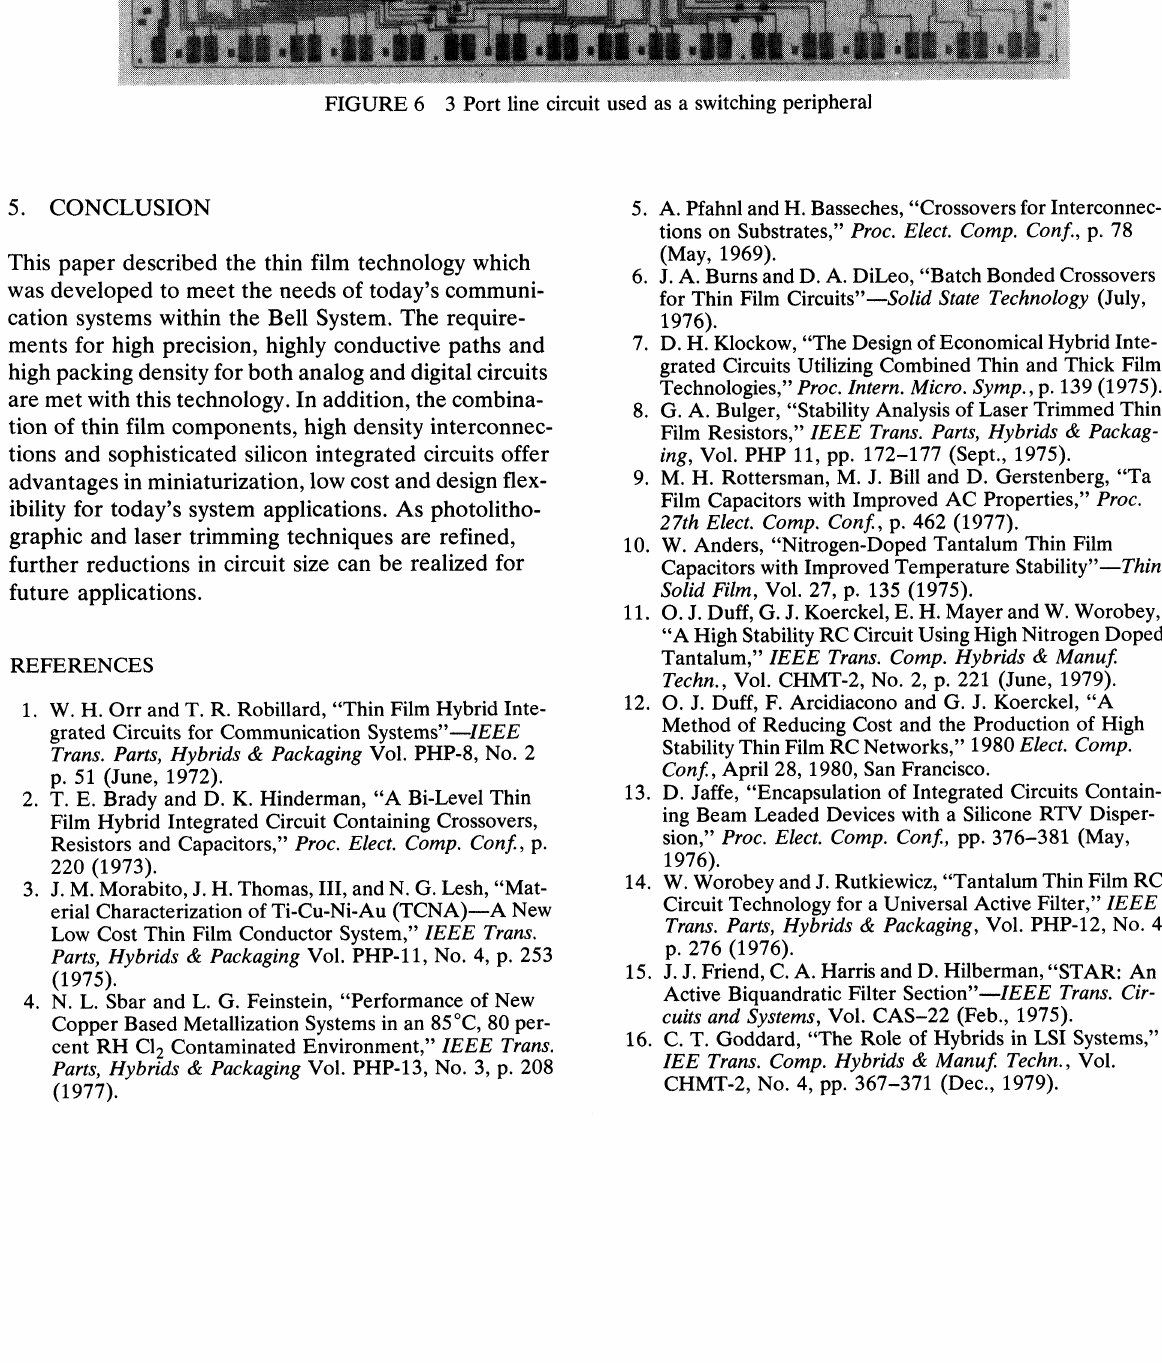
FIGURE 6 3 Port line circuit used as a switching